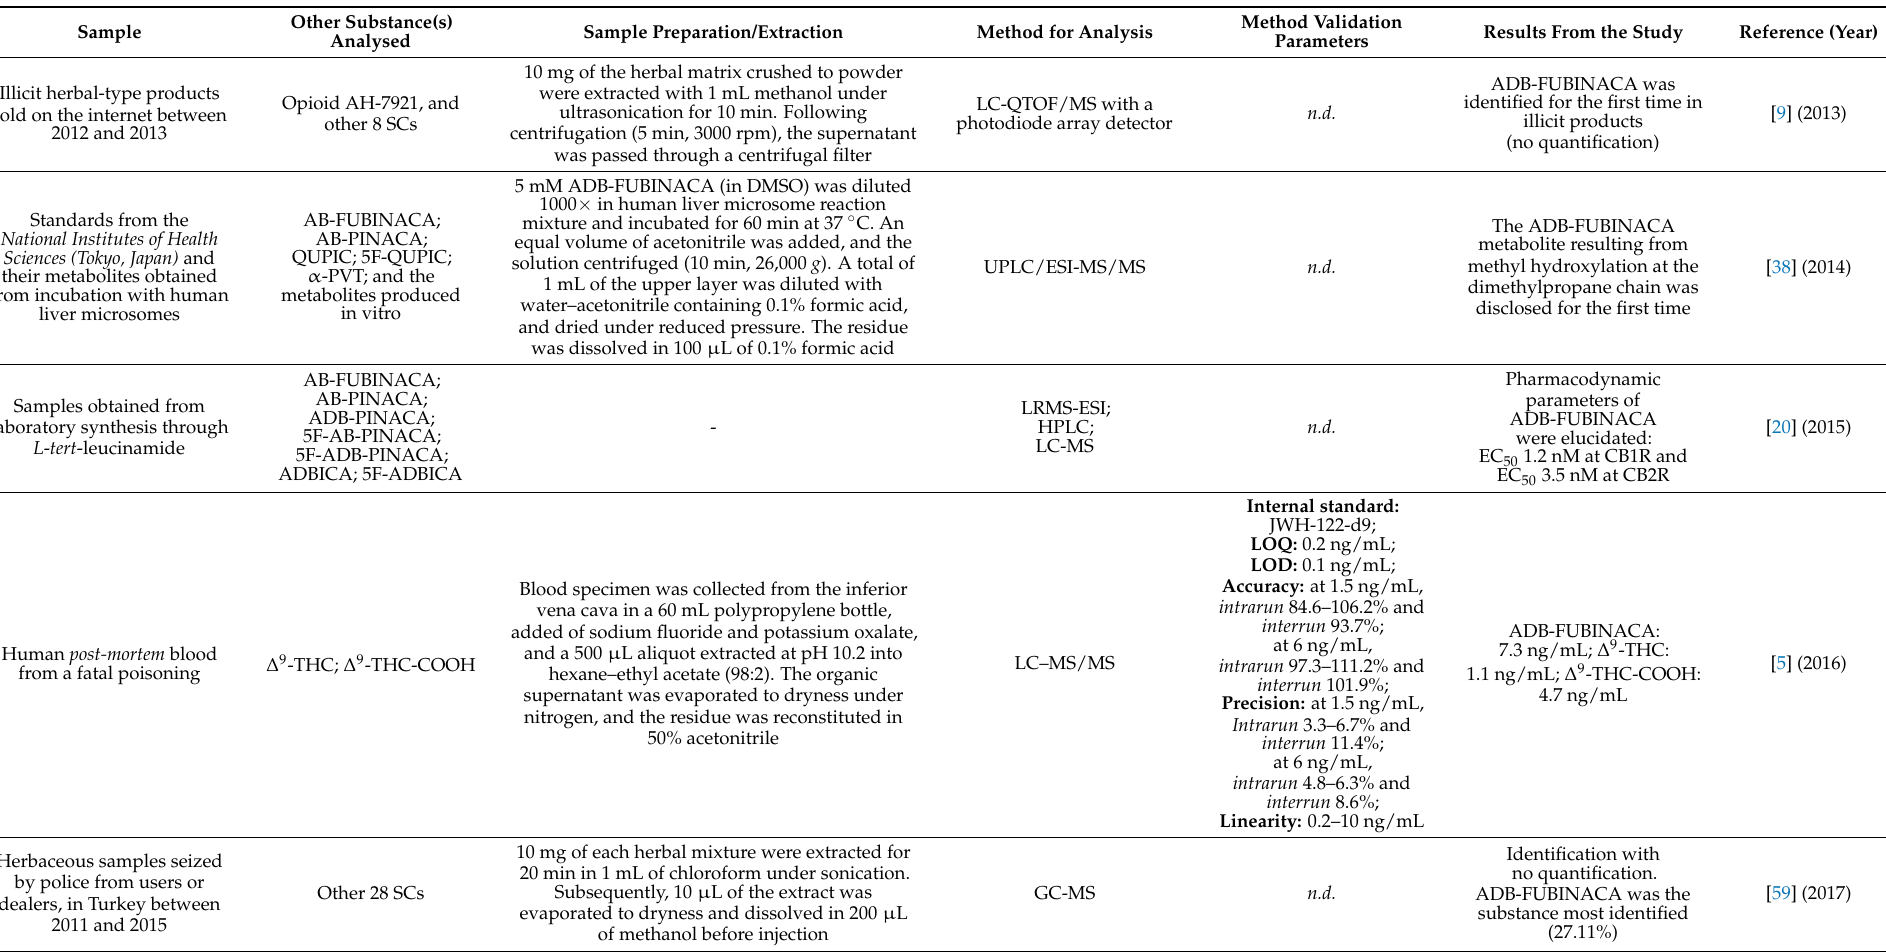
Table 2. Analytical techniques for the identification and quantification of